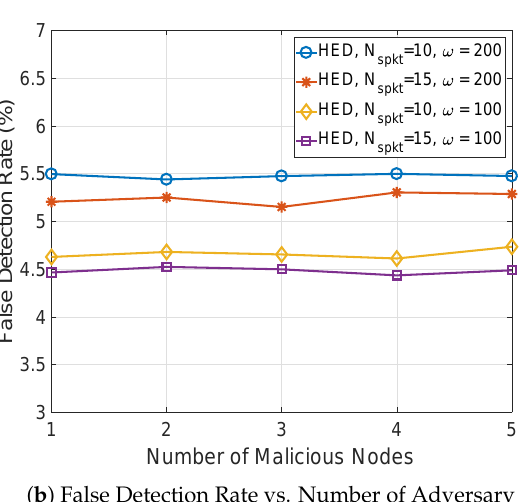
( a ) False Detection Rate vs. Attack Frequency